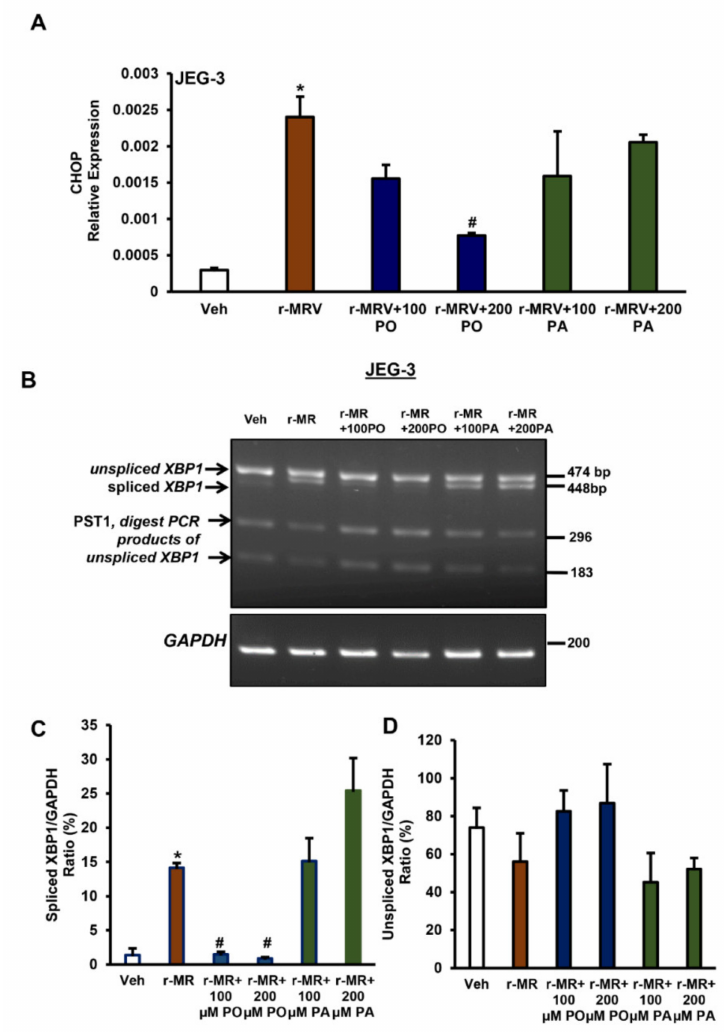
Figure 6. Palmitoleate protects against ZIKV-induced ER stress but not palmitate. ( A ) CHOP mRNA expression was significantly upregulated with 0.1 MOI r-MRV 48 hpi in JEG-3 cells compared to uninfected control cells. There was significant reduction in CHOP mRNA expression in JEG-3 cells treated with 200 µ M of palmitoleate 48hpi with ZIKV suggesting protective role of palmitoleate against ZIKV-induced apoptosis and a trend towards decreased expression with 100 µ M palmitoleate treatment, but this was not seen with the treatment of 100 or 200 µ M palmitate to r-MRV-infected cells. ( B ) Similarly, there was increase in XBP1 mRNA splicing in infected cells (band ~448 bp) when compared to uninfected vehicle cells. There was significant inhibition of XBP1 mRNA splicing with the treatment of 100 or 200 µ M of palmitoleate in ZIKV-infected cells. However, the protective properties were not seen with the treatment of palmitate to ZIKV-infected cells. ( C ) Quantified levels of spliced XBP1 mRNA (448 bp) relative to GAPDH (Spliced XPB1/GAPDH). ( D ) Quantified levels of unspliced XBP1 mRNA (474 bp) relative to GAPDH (Unspliced XPB1/GAPDH). Data represent mean ± SEM, n = 3. * p < 0.05 compared to uninfected vehicles cells, # p < 0.05 compared to ZIKV-infected